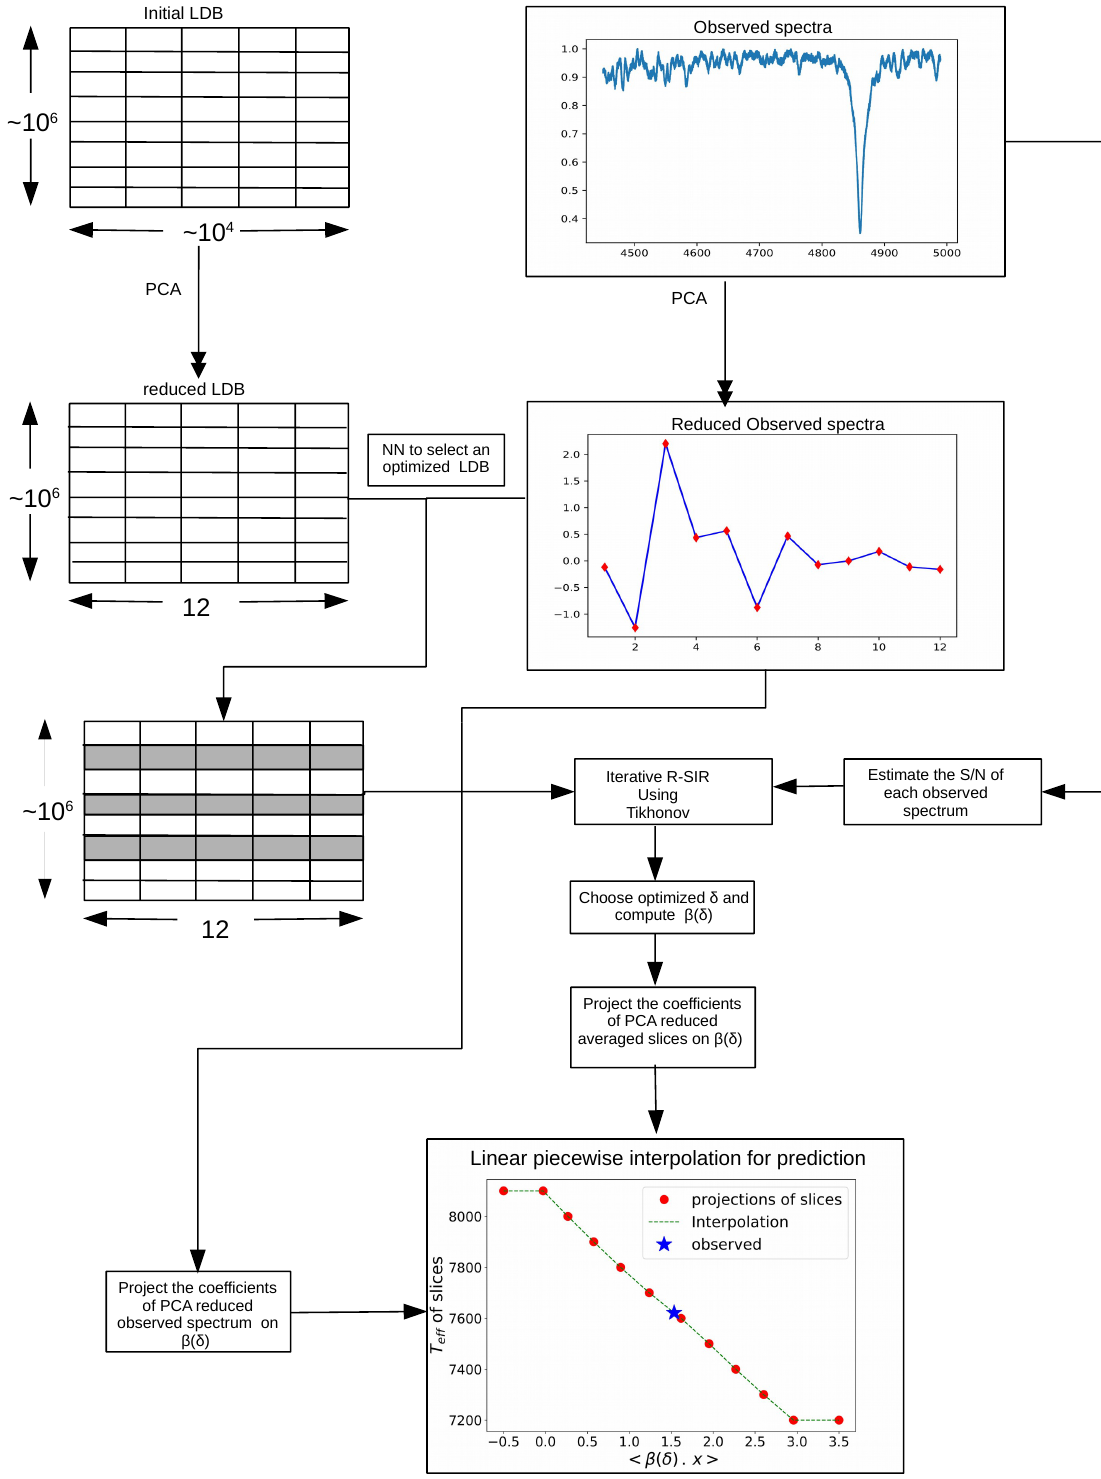
Figure 1. The flowchart of the procedure. The numerics in this figure are for the inversions of the test described in Sec.